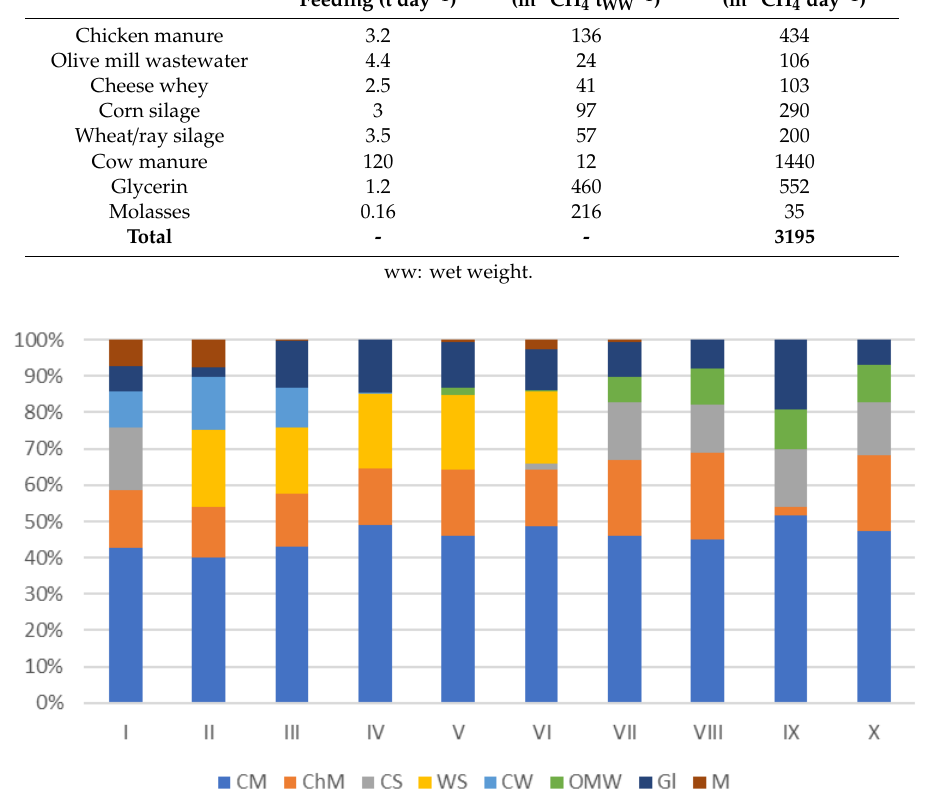
Figure 3. Fractional composition (% w / w as kgCOD) of each of the 8 feedstocks for the different operational phases.